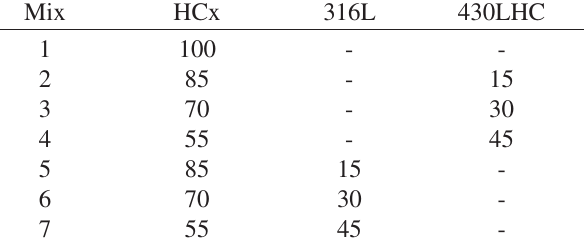
Table 3. Composition of the mixes prepared (% in